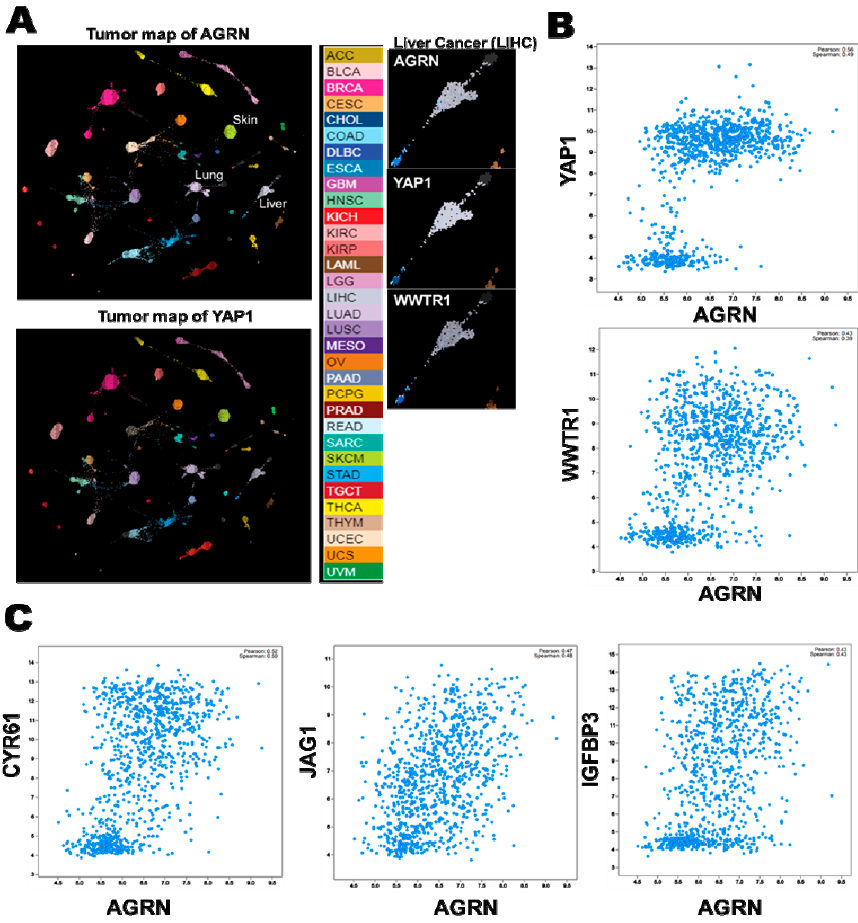
Figure 6. Interactive mapping of Agrin and YAP/TAZ expression profiles across different cancer types. ( A ) Tumor map patterns of AGRN and YAP1 mRNA expression (generated by UCSC tumor map using the TCGA_TARGET_GTEX dataset). The expression patterns of AGRN and YAP1 mRNA are closely matched in several cancer types (Color coded). The panels on the extreme right indicate the relative expression levels of AGRN, YAP1 and WWTR1 (TAZ) in liver cancer (LIHC). The intensity map of expression is indicated below. ( B ) Correlation between AGRN and YAP1/WWTR1 mRNA across cancer cell lines (Cancer Cell Encyclopedia-Novartis/Broad Institute dataset). ( C ) Correlation between agrin and YAP target gene expressions across cancer cell lines.